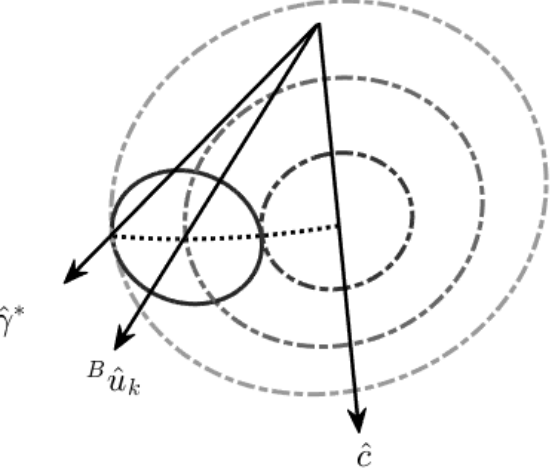
Figure 7. Geometry for case 2: all components of the vector ˆ c are equal, and ∆ v reaches its minimum at the intersection of the circle and the farthest circle around ˆ c , that is at ˆ γ ∗ .